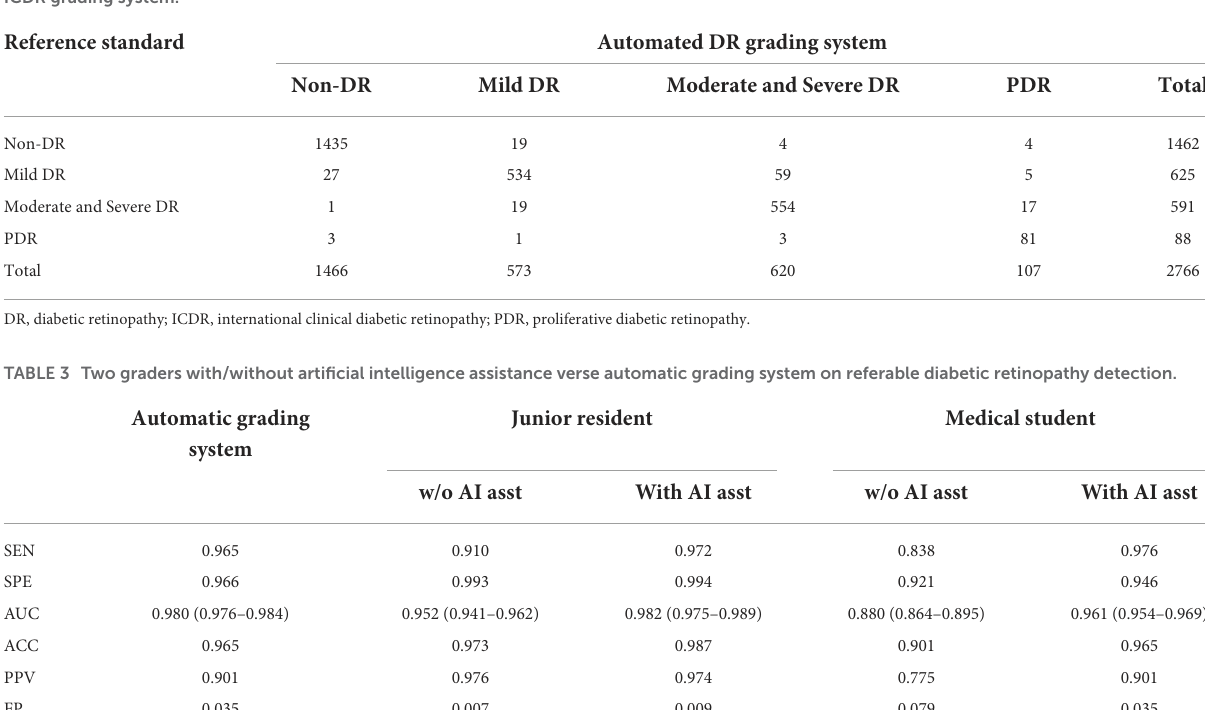
TABLE 2 Confusion matrix for adjudicated reference standard and automatic DR grade system output according to modified protocol based on ICDR grading system.